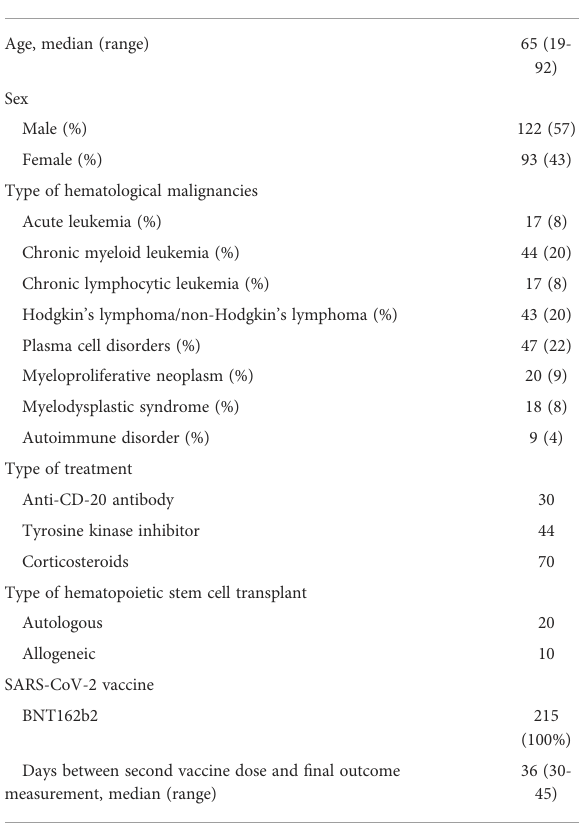
TABLE 1 Clinical characteristics of